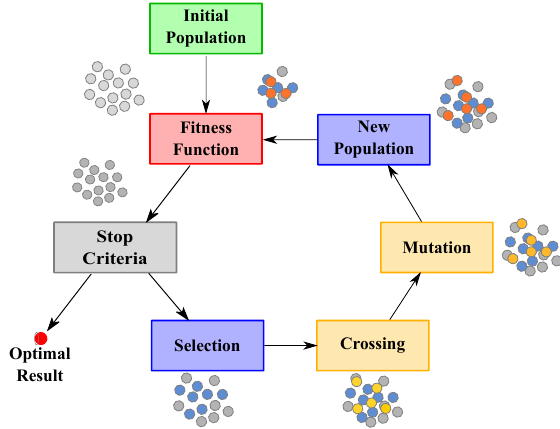
Figure 4. Flowchart of basic GA architecture used for tuning the LQR